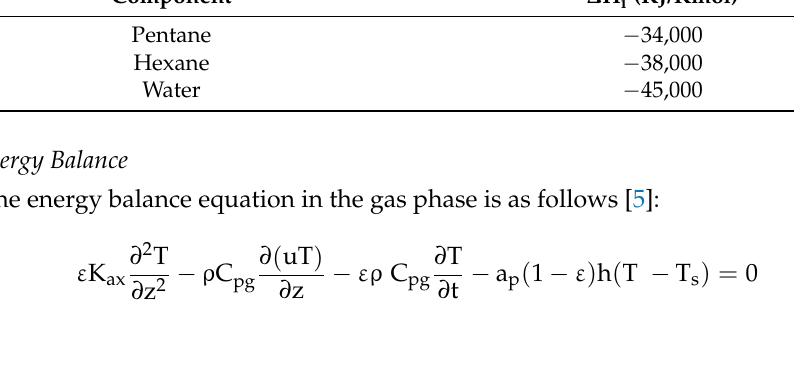
Figure 3. View of the four beds in a complete cycle (A: adsorption, C: cooling, H: heating).